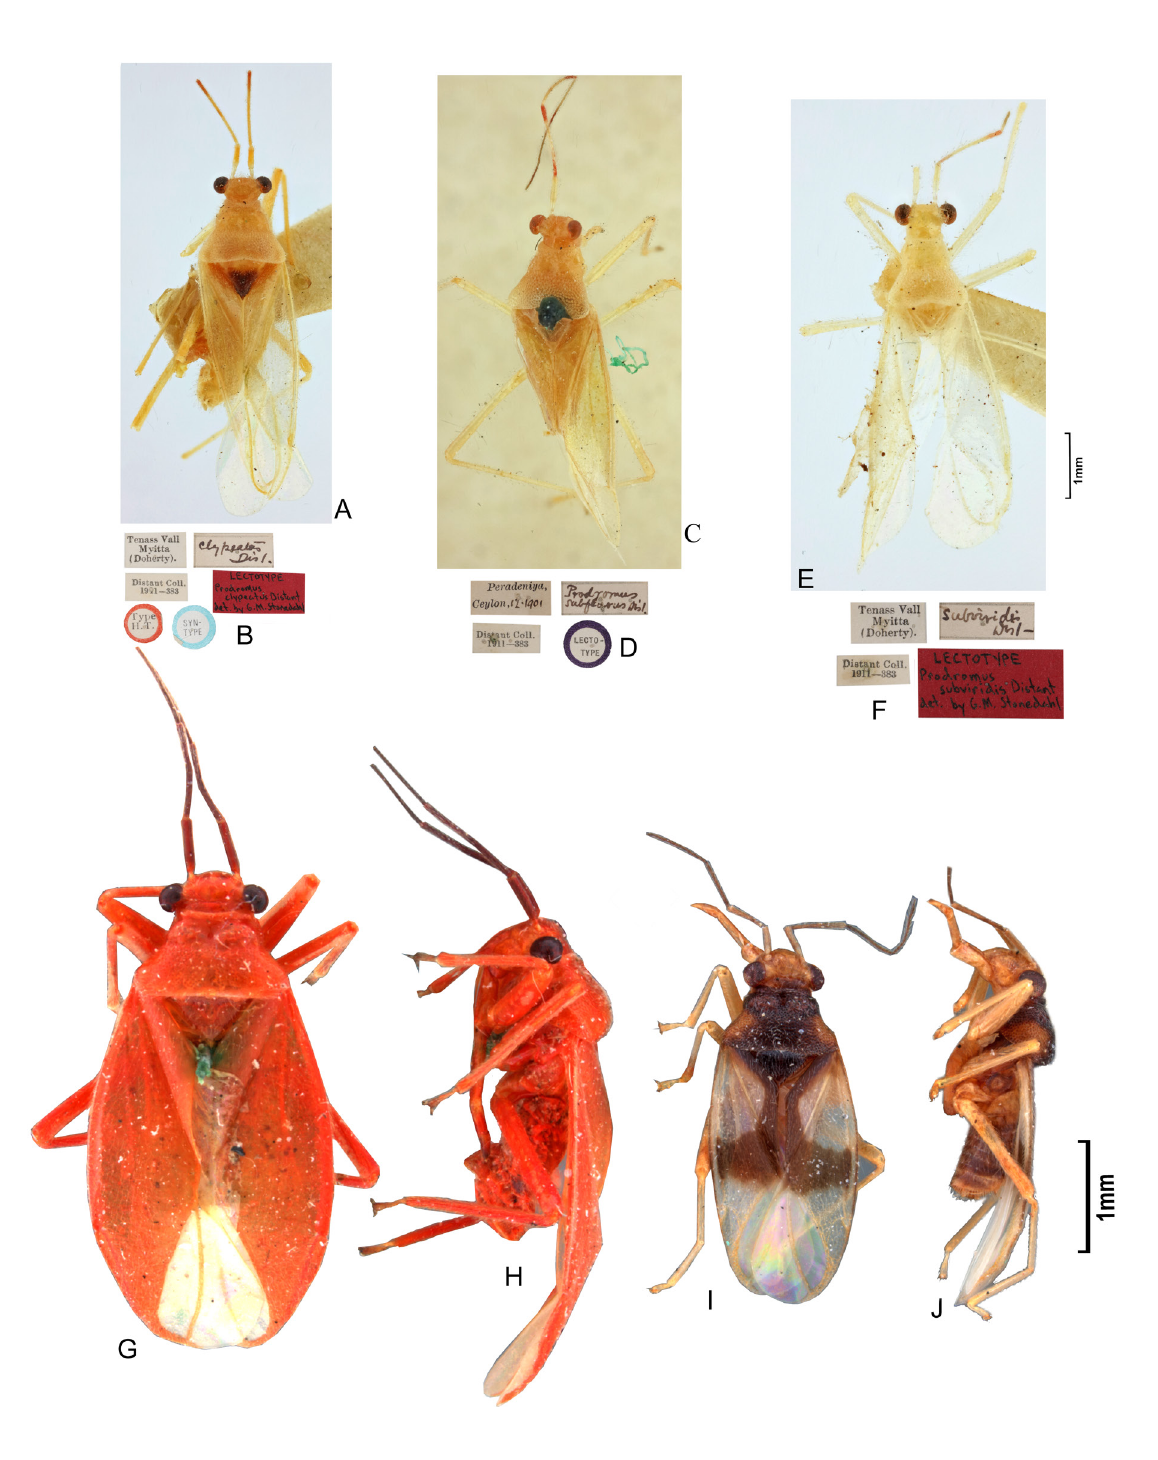
Fig. 9. Dorsal view and label data of type specimens. A–B . Prodromus clypeatus Distant, 1904, ♀, lectotype, AMNH_PBI 00340350, NHM. C–D . Prodromus subflavus Distant, 1904, ♂, lectotype,